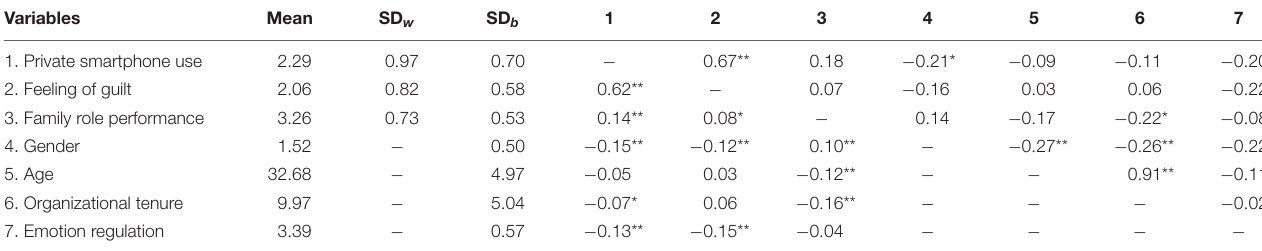
TABLE 1 | Descriptive statistics and correlations among study variables.